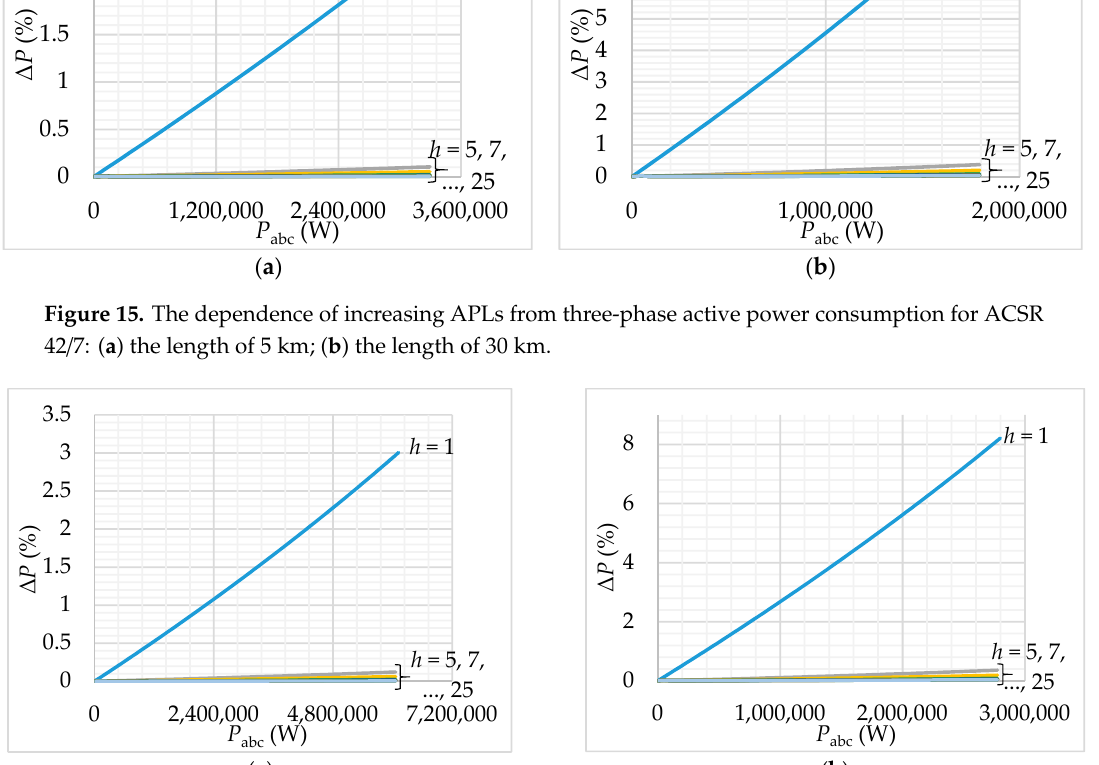
Figure 16. The dependence of increasing APLs from three-phase active power consumption for ACSR 70/11: ( a ) the length of 5 km; ( b ) the length of 30 km.